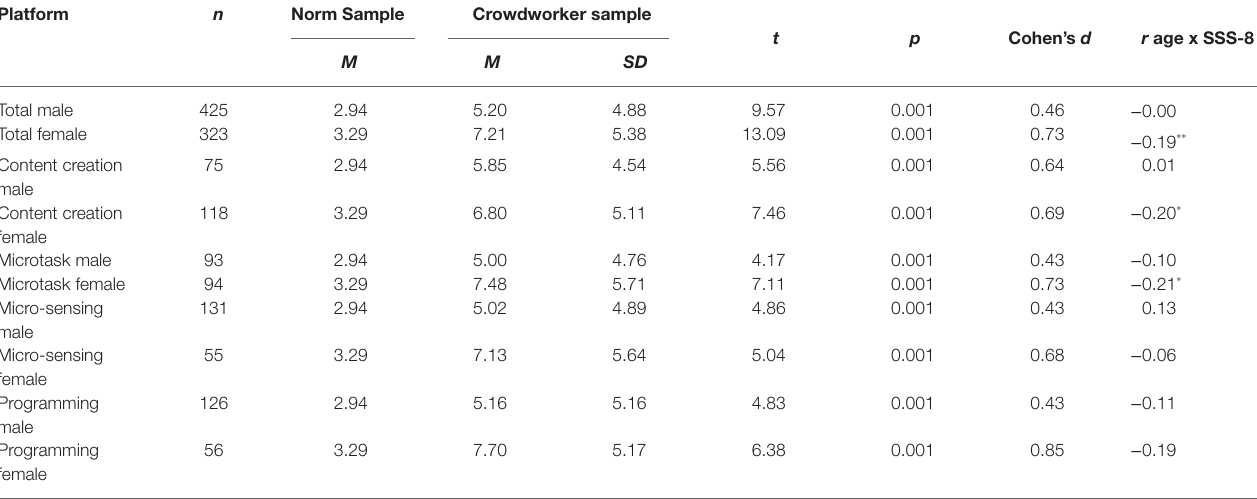
TABLE 3 | Results of mean differences analyses of SSS-8 mean sum scores of the crowdworker sample compared to the norm sample per crowdwork platform & relation with age.